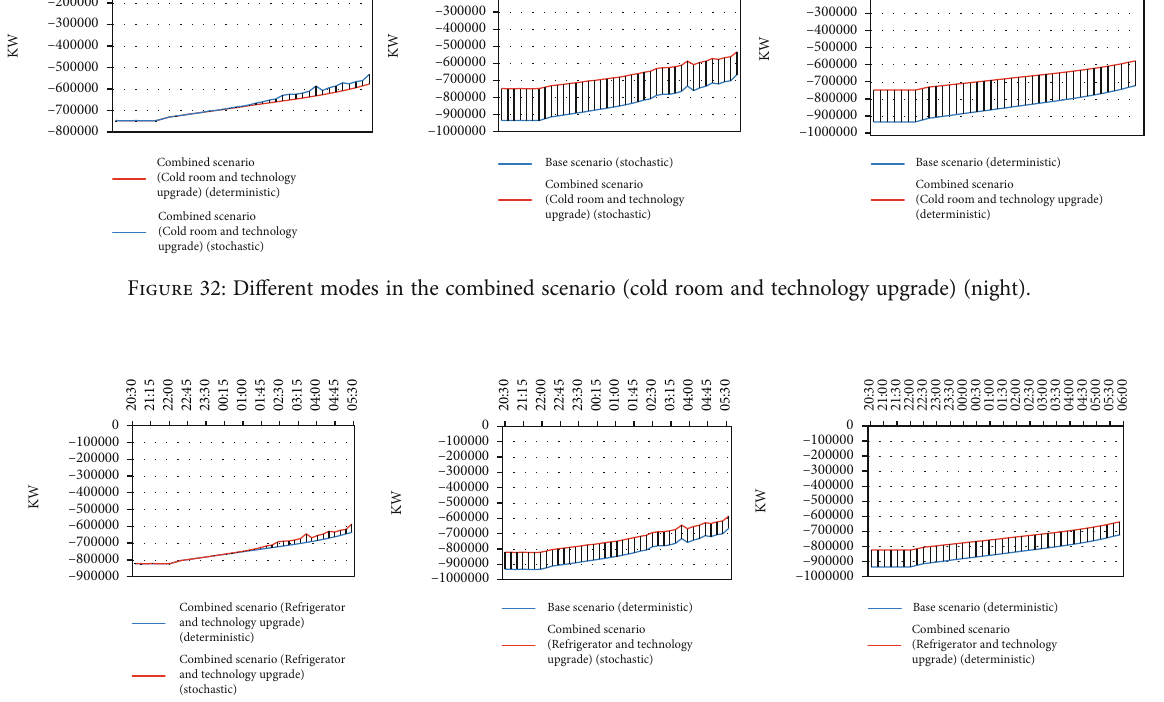
Figure 33: Di ff erent modes in the combined scenario (refrigerator and technology upgrade)